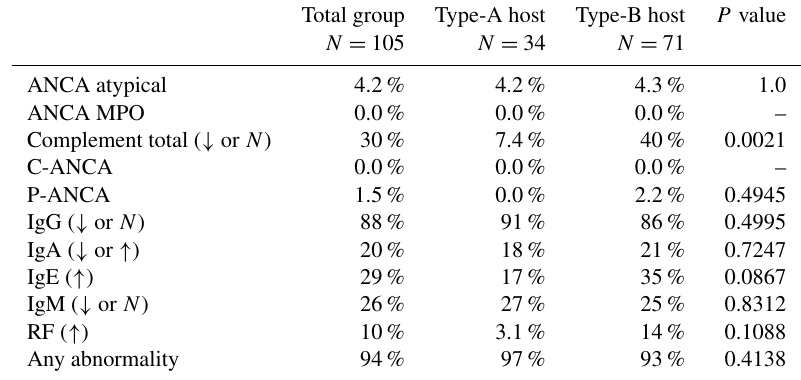
Table 3. Host status comparison of immunological laboratory assessments – clinically significant abnormalities incidence.